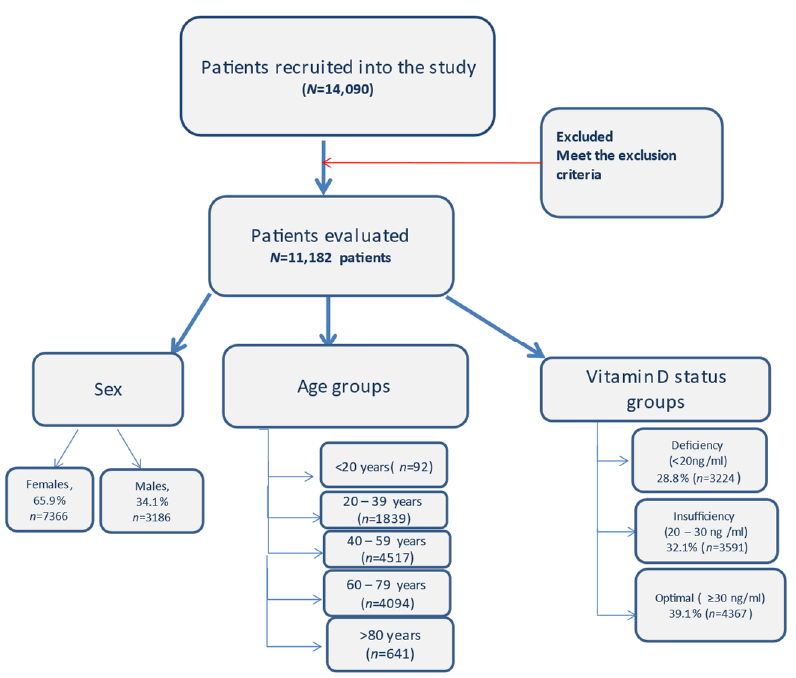
Figure 1. Flow diagram with the patients included in the study and the distribution.